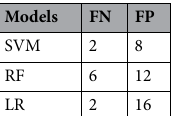
Table 2. Cost matrix of